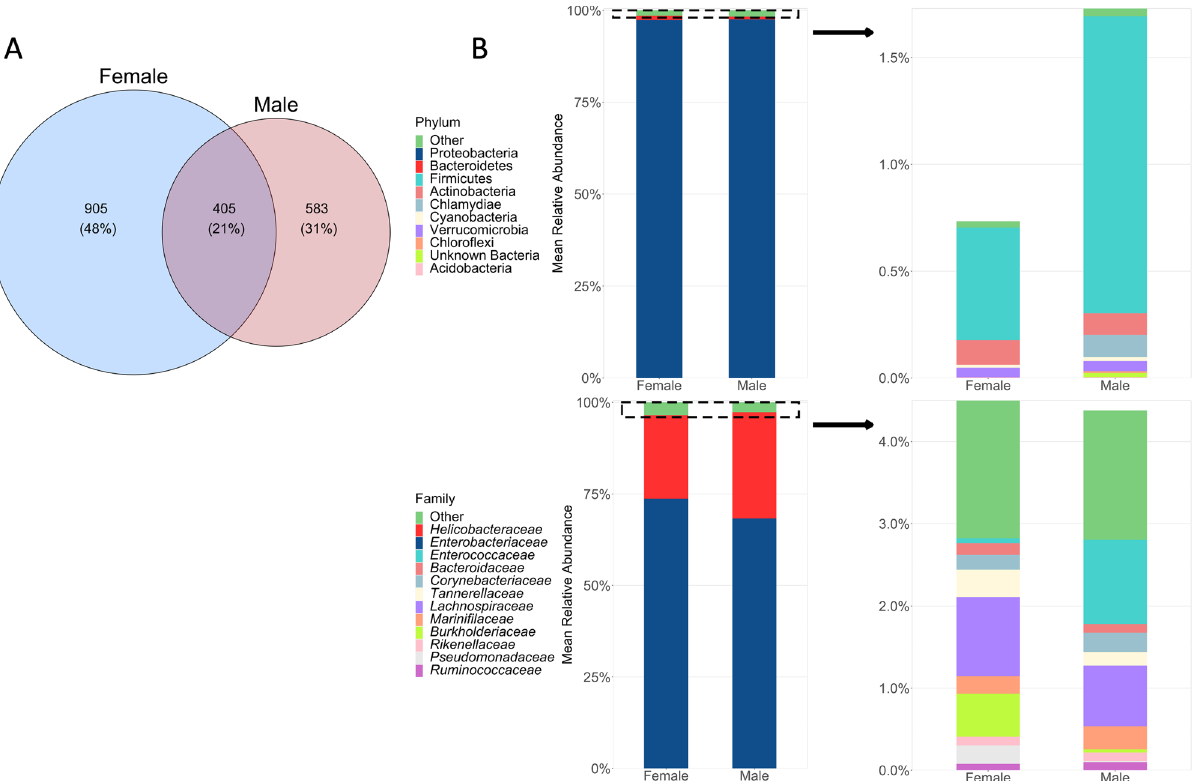
Figure 3. ( A ) Overlap of ASVs recovered from male and female S. virgatus cloacal microbiomes. ( B ) Percent composition of cloacal microbiomes in male and female S. virgatus . In the left-side plots, different colors of the bars represent the relative abundance of the top 2 most abundant phyla and families; the remaining taxa were combined into the “other” category. Within that category, the next 10 most abundant taxa are represented by different colors on the right-side plots, and the remaining taxa again grouped into the “Other” category. The y-axis of both panels indicates the average percent of total reads for each sex that each taxa